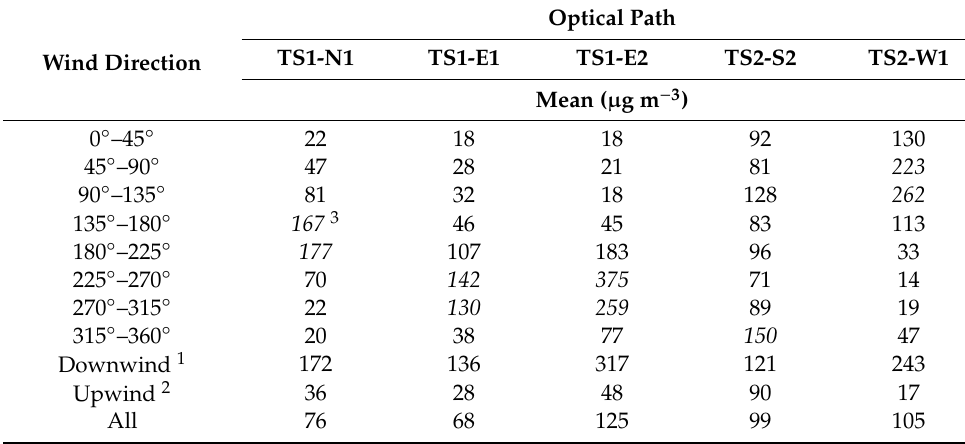
Table 2. Characteristics of the TDL path NH 3 concentrations.